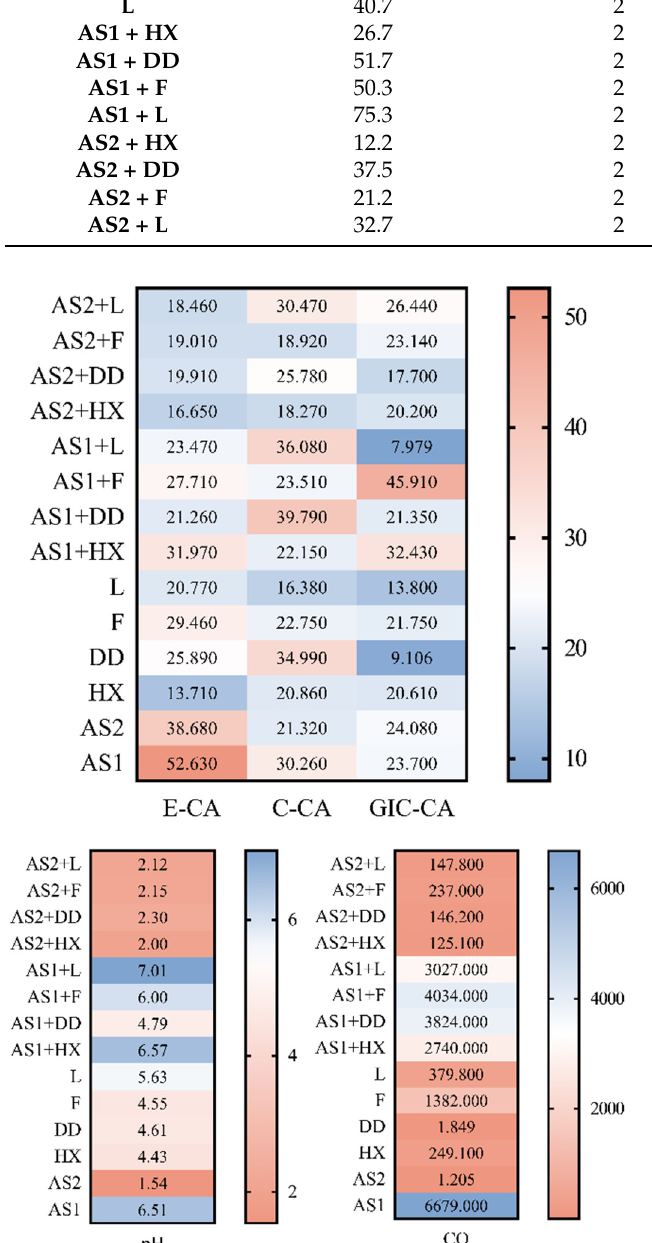
Figure 7. Heat map showing the relationship among contact angle range, pH range, and conductivity range in 14 analyzed specimens. Comparison of data obtained using Image J software and the MATLAB algorithm showed consistency, not exceeding 5%